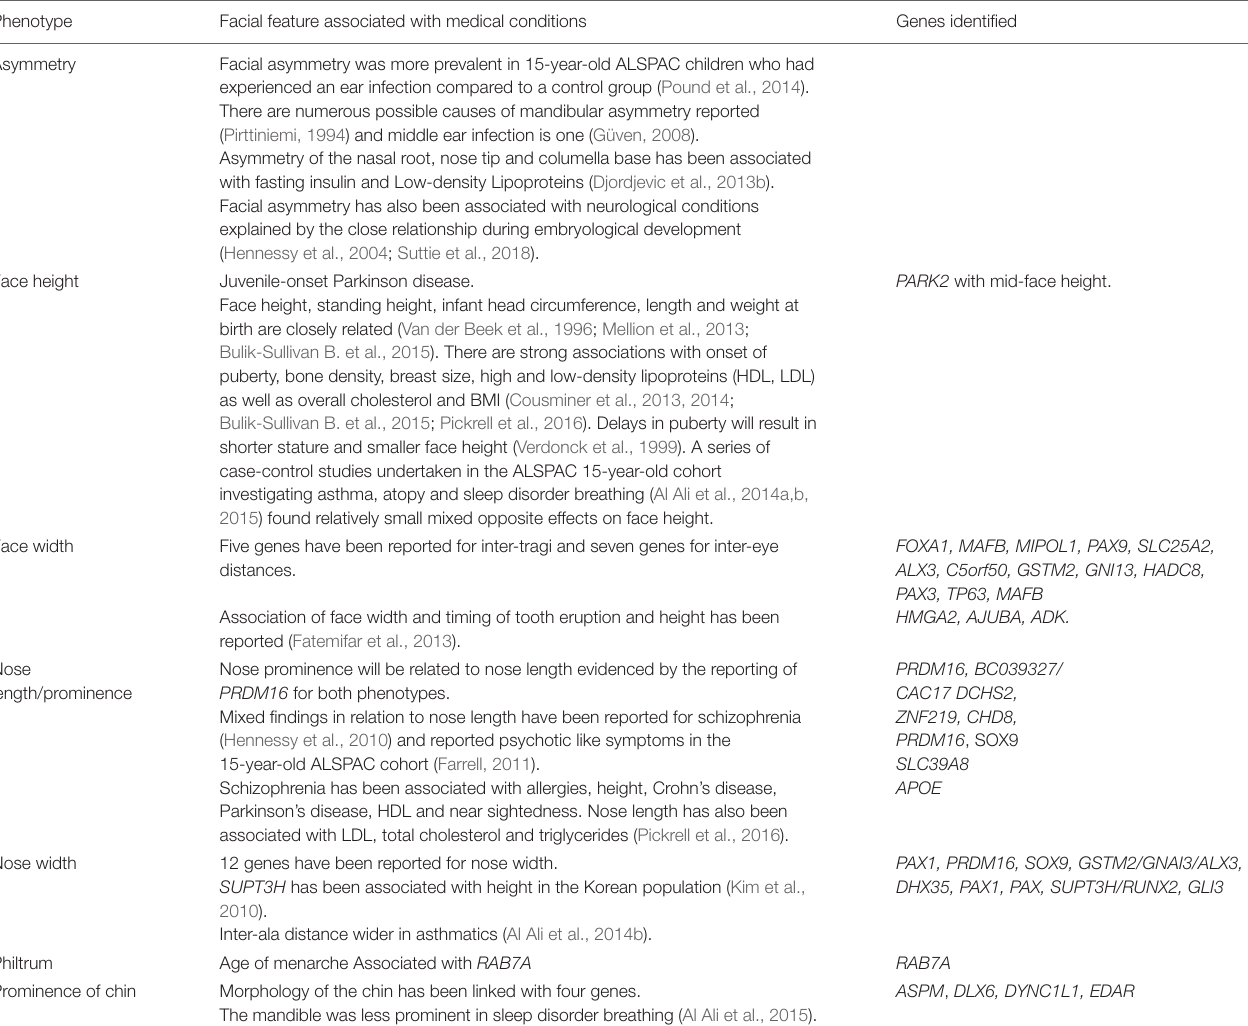
TABLE 3 | Reported shared influences of medical conditions, normal facial variation with associated